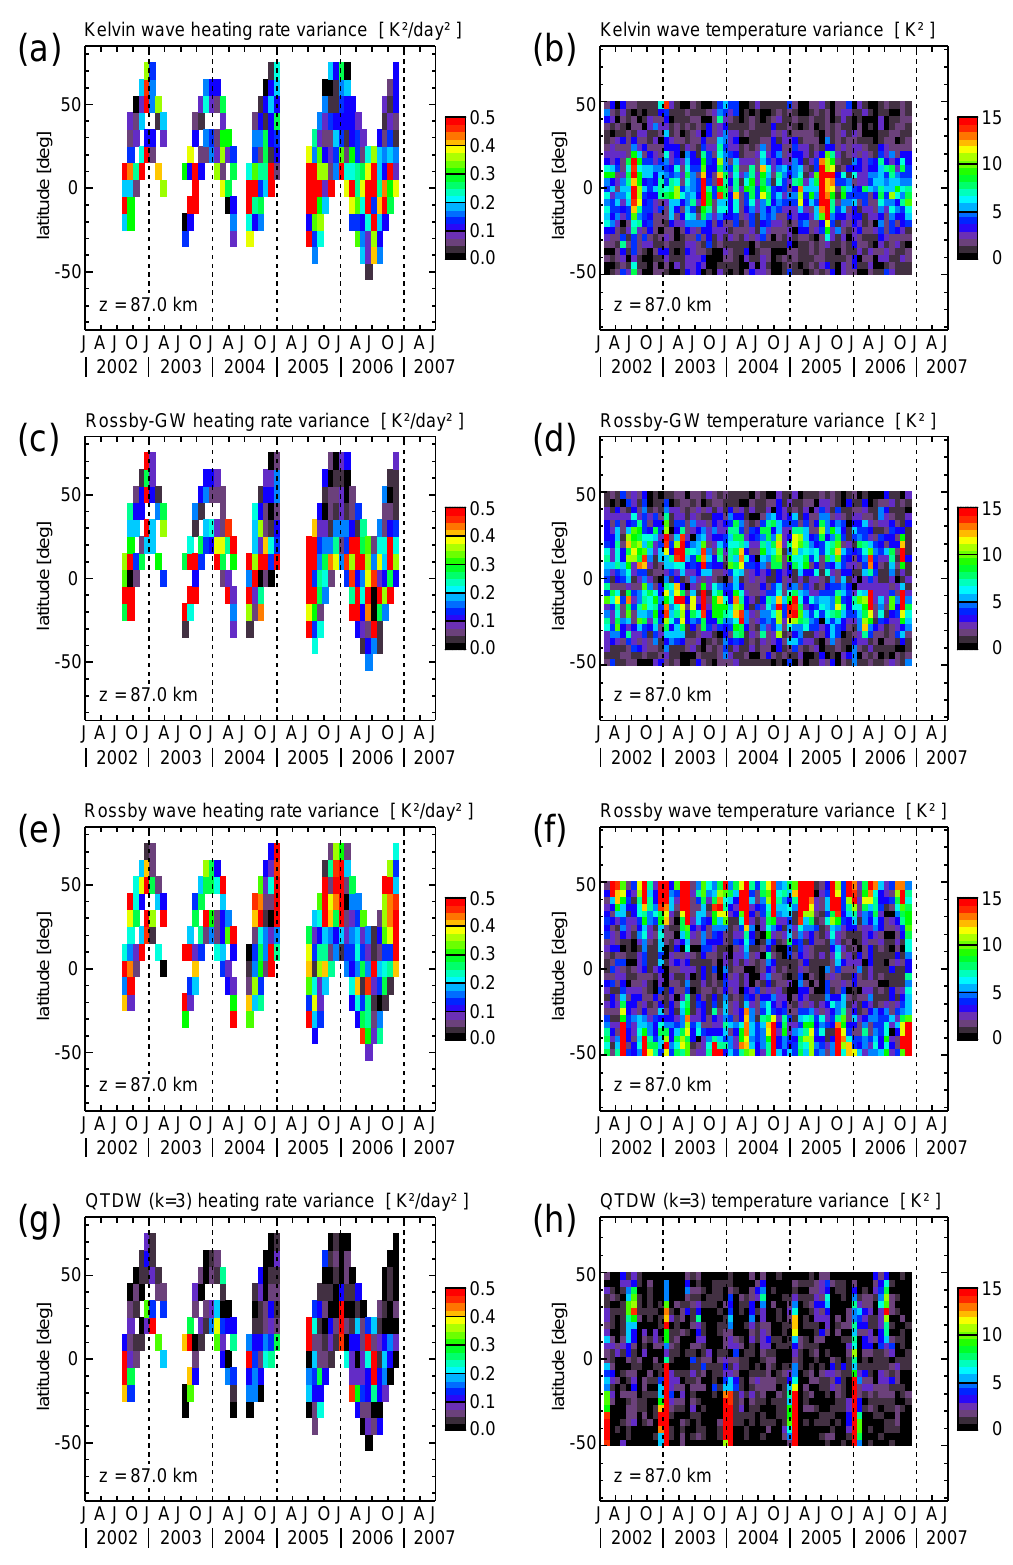
Fig. 3. Variances for different wave bands determined from SCIAMACHY (left column) and SABER (right column) space-time spectra at 87km altitude. Shown are variances due to Kelvin waves ( a and b ), Rossby-gravity waves ( c and d ), Rossby waves ( e and f ), and quasi-2-day waves with zonal wavenumber 3 ( g and h